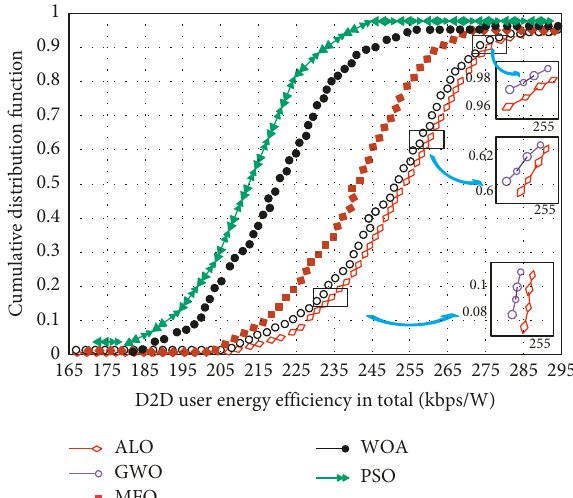
Figure 4: Cumulative distribution function (CDF) curve of the sum of energy efficiency of D2D users in the system.